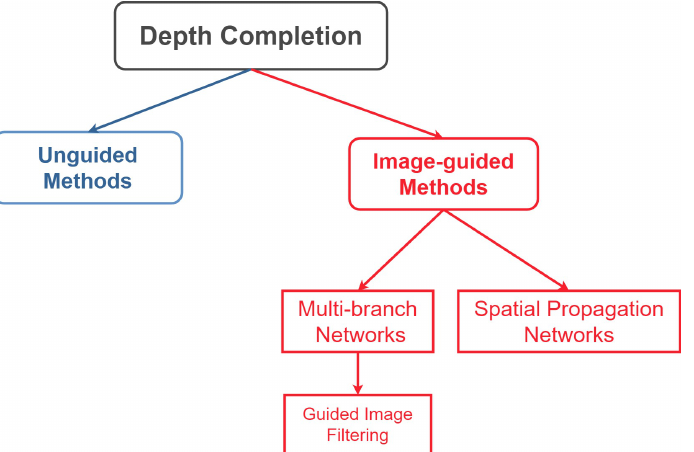
Figure 2. Approaches to depth completion problem. Unguided approaches utilize either only LiDAR information or confidence maps and LiDAR information for dense depth completion. The image- guided methods (multi-branch and spatial propagation networks) employ guidance images (RGB, semantic maps, surface normals) to guide the process of depth completion. The multi-branch networks can be further divided into guided image filtering methods, which aim to learn useful kernels from one modality and apply it to other